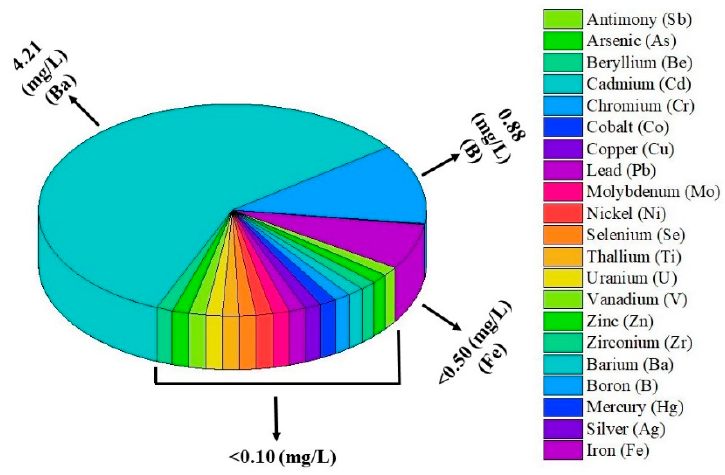
Figure 7. Toxicity Characteristic Leaching Procedure (TCLP) test results of bottom-ash based GPC.